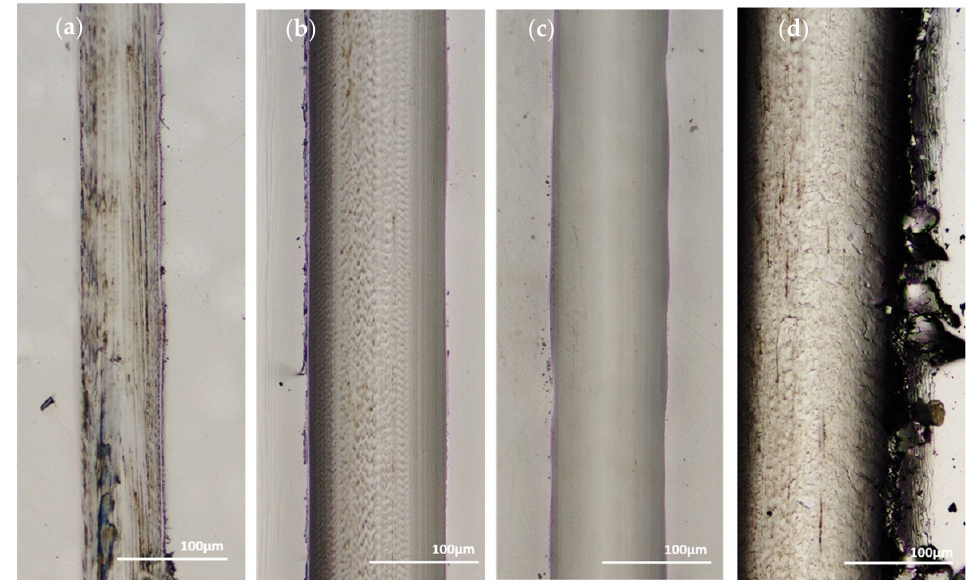
Figure 23. One hundred Passes of the Sharp Indenter on the Surface of: ( a ) 45 μ m Thick Ni-P, ( b ) 9 μ m Thick Ni-P, ( c ) 9 μ m Thick Ni-P-NiTi, ( d ) 4 μ m Thick Ni-P-NiTi.